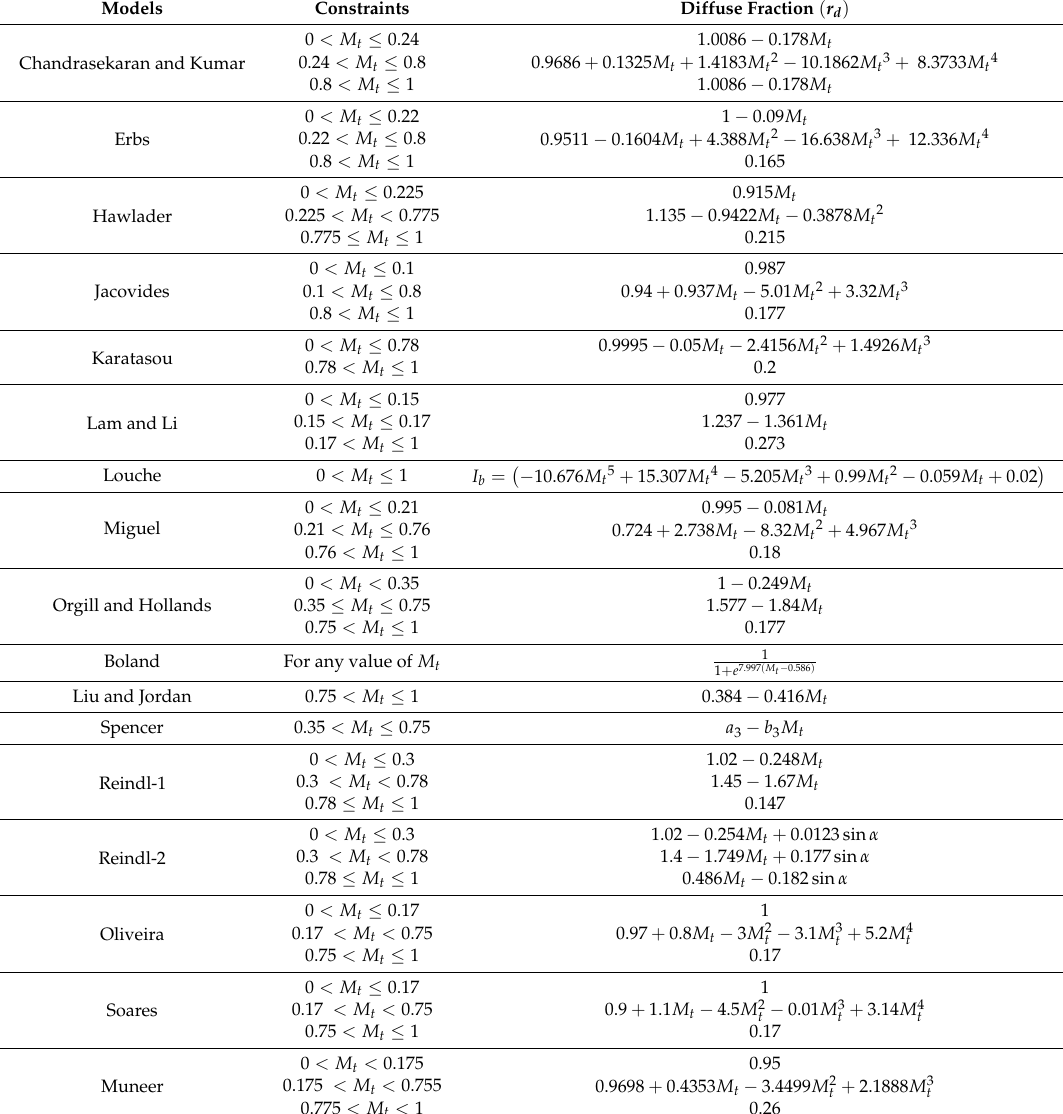
Table 2. Summary of the parametric